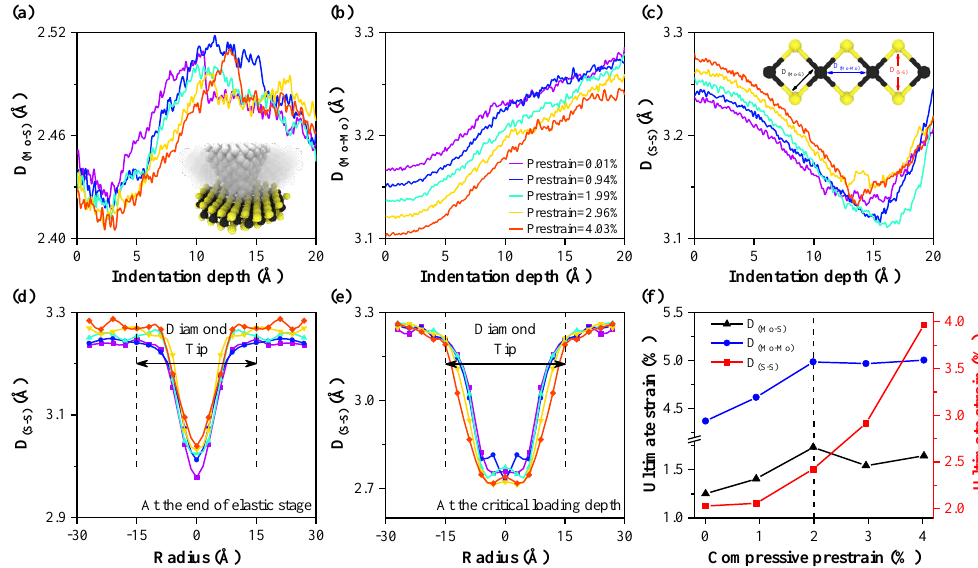
Figure 5. Evolution of D (Mo–S) ( a ) D (Mo–Mo) ( b ) and D (S–S) ( c ) for atoms in the contact area between the diamond tip and MoS 2 during the indentation process. Radially averaged distance distribution of D (S–S) for MoS 2 at the end of the elastic stage ( d ) and at the critical loading depth ( e ), which is obtained by averaging the D (S–S) from the center of the contact area at radial intervals of 3.0 Å. ( f ) The ultimate strains of D (Mo–S) , D (Mo–Mo) , and D (S–S) before the critical loading depth of each model, respectively.